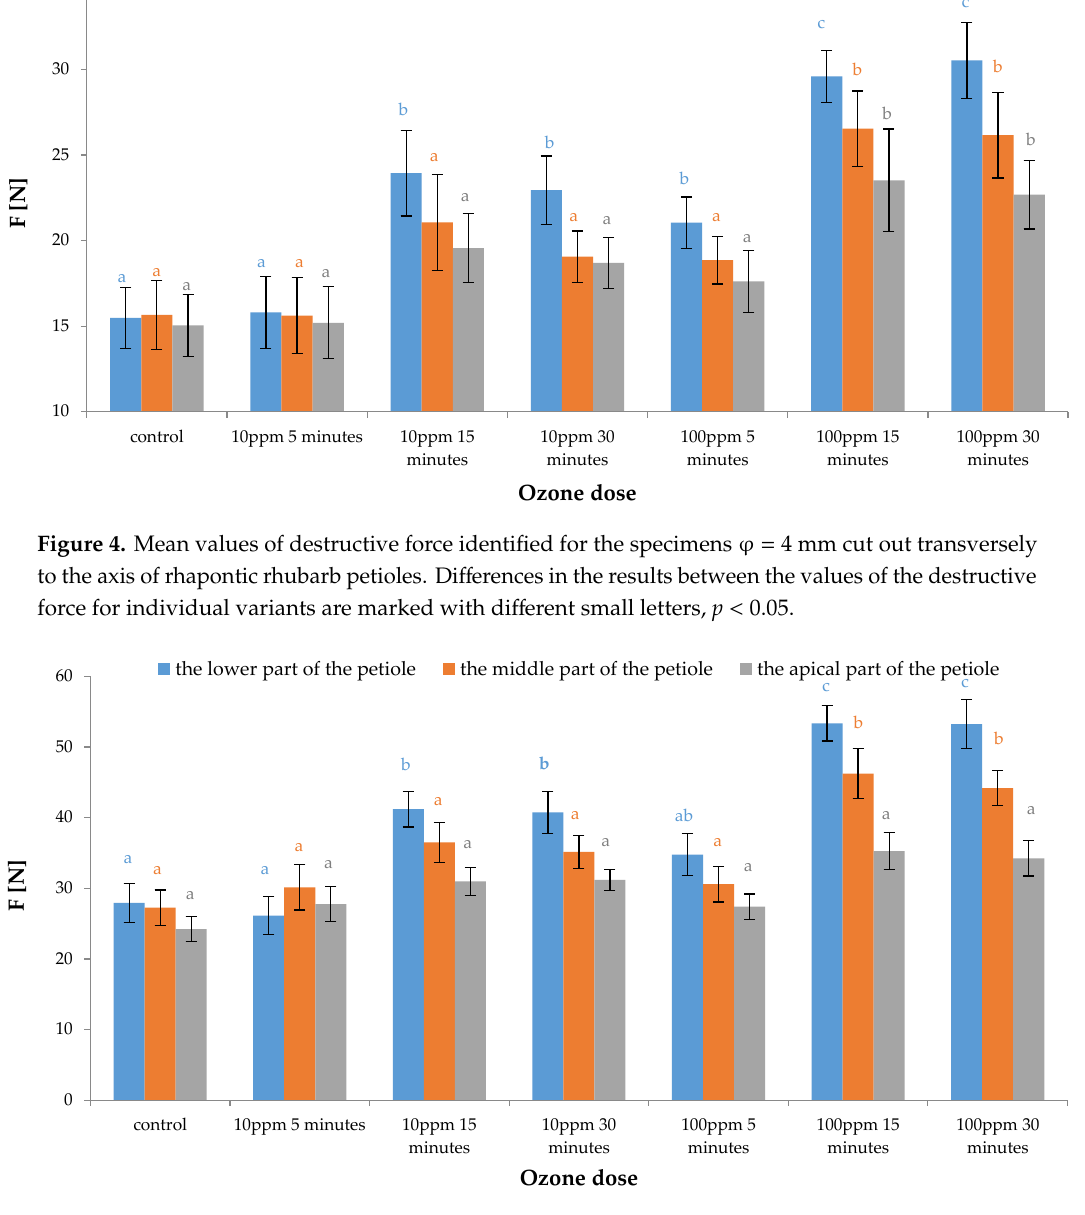
Figure 5. Destructive force identified for the specimens φ = 4 mm cut out along the axis of rhapontic rhubarb petioles. Differences in the results between the values of the destructive force for individual variants are marked with different small letters, p < 0.05.